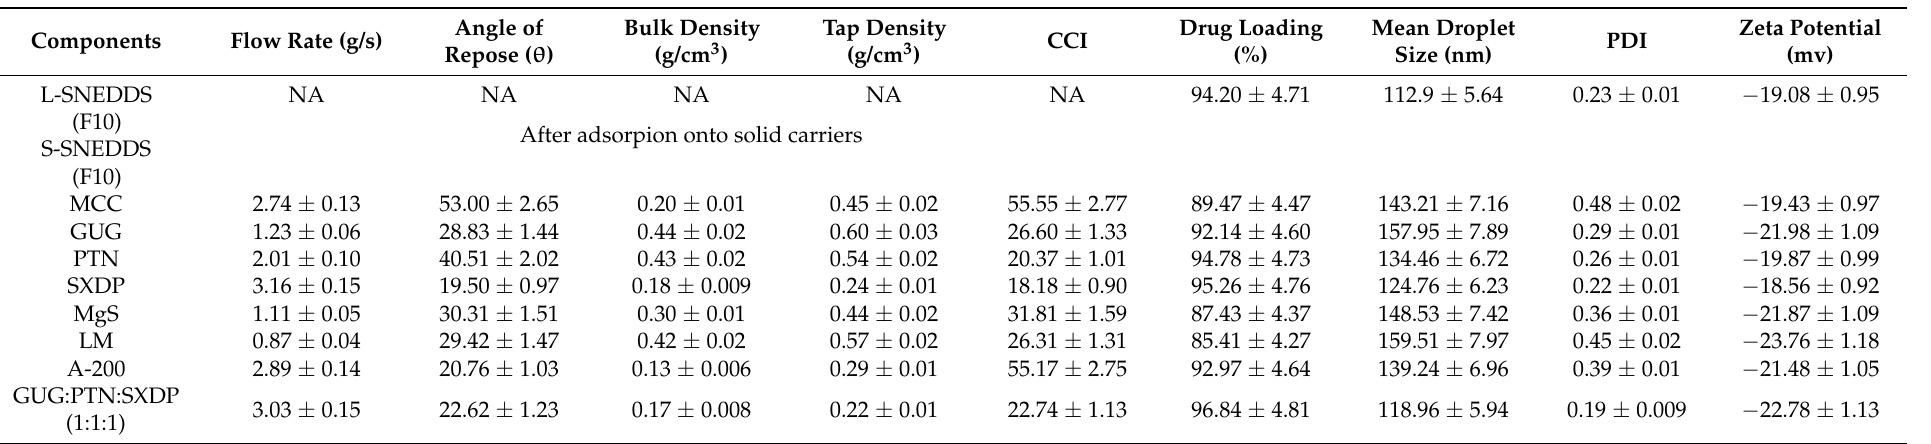
Table 3. Pre-compression characteristics of S-SNEDDS (n = 3, mean ±